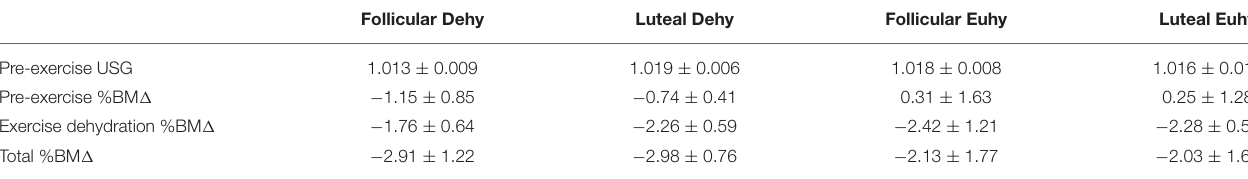
TABLE 1 | Pre-exercise USG and %BM 1 observed between dehydrating